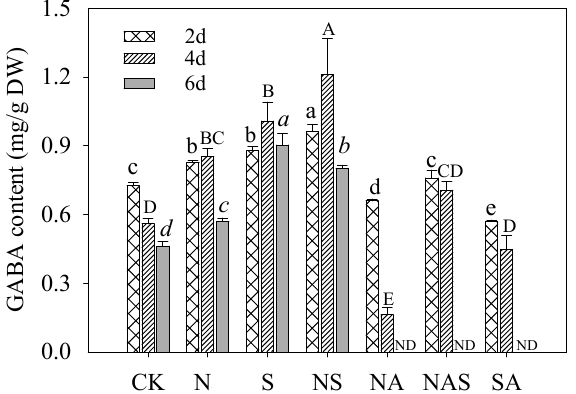
Figure 4. E ff ect of Spd on γ -aminobutyric acid (GABA) content in germinating soybeans. Lowercase Figure 4. Effect of Spd on γ- aminobutyric acid (GABA) content in germinating soybeans. letters reflect the significance of di ff erences in index among treatments of 2-day germinating soybeans, Lowercase letters reflect the significance of differences in index among treatments of 2-day capital letters reflect the significance of di ff erences of 4-day germinating soybeans, and lowercase letters in italics reflect the significance of di ff erences of 6-day germinating soybeans ( p < 0.05). CK, Control; N, NaCl; S, Spd; NS, NaCl + Spd; NA, NaCl + AG; NAS, NaCl + AG + Spd; SA, Spd + AG; AG, Aminoguanidine; ND, Non